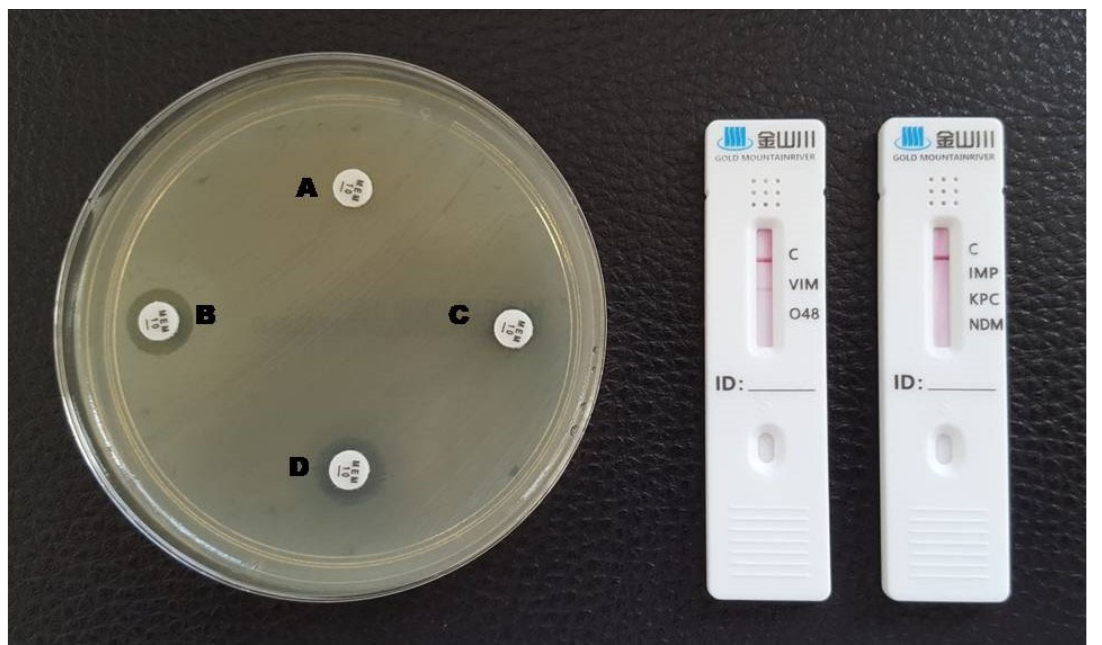
Figure 5. Phenotypic and lateral flow assay results for a VIM-producing P. aeruginosa . A: meropenem disc without inhibitors; B: meropenem + EDTA; C: meropenem + phenylboronic acid; D: meropenem + EDTA + phenylboronic acid. A red line in the VIM test area is visible in the LFA.